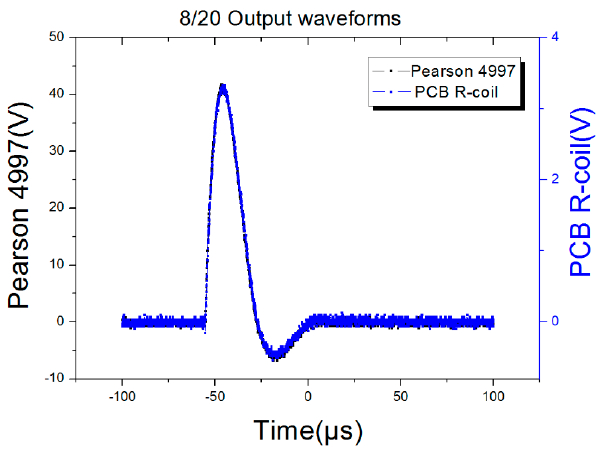
Figure 16. 8/20 impulse current output waveforms.